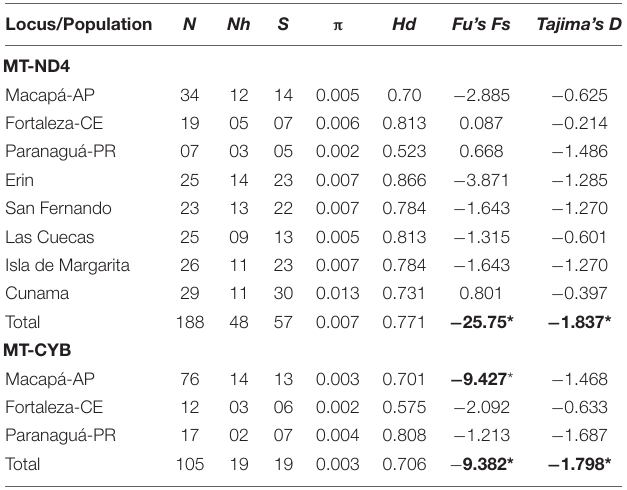
TABLE 3 | Matrix of the values of the Fst fixation index for the MT-ND4 gene sequences from eight S. brasiliensis localities on the coast of Venezuela, Trinidade and Tobago, and